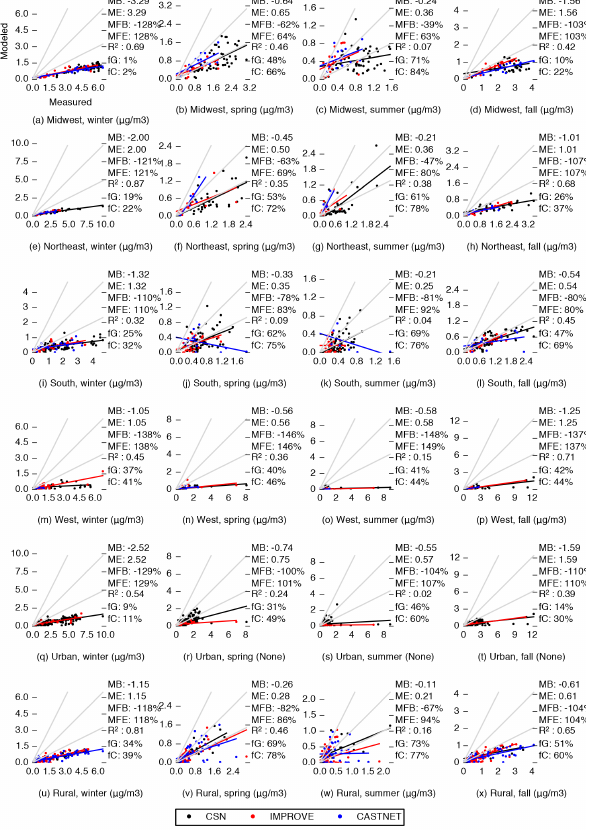
Figure 10. Comparison of modeled and measured particulate EC concentrations, disaggregated by region and